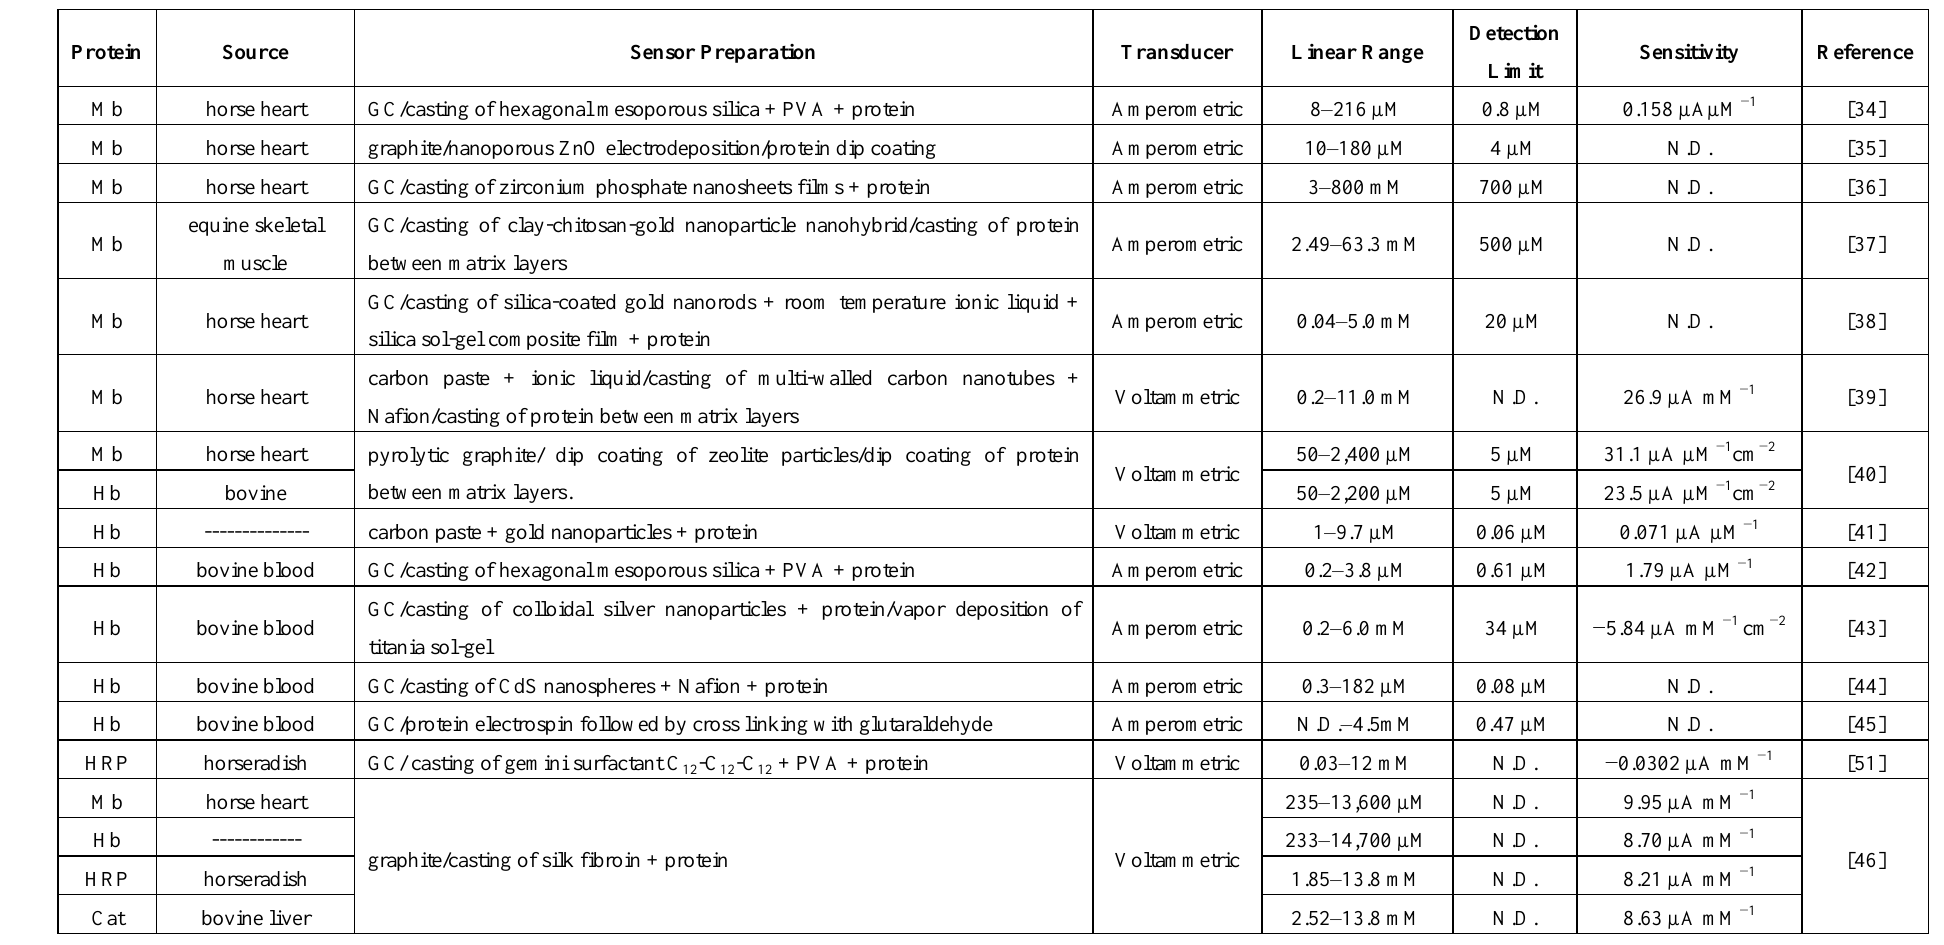
Table 1. Description and analytical parameters of nitrite biosensors based on non-specific proteins (N.D. – not